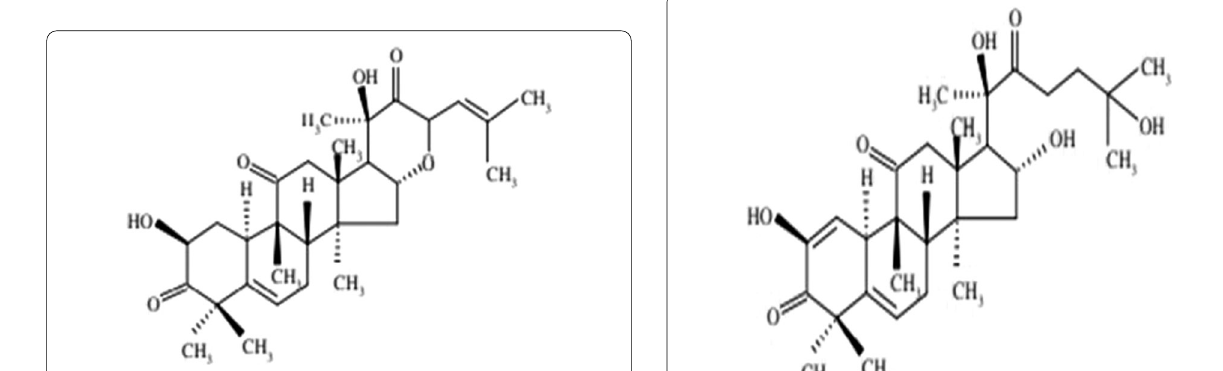
Fig. 1 Molecular structures of some bio-active agents of Bryonia alba L. 22-deoxocucurbitosides A